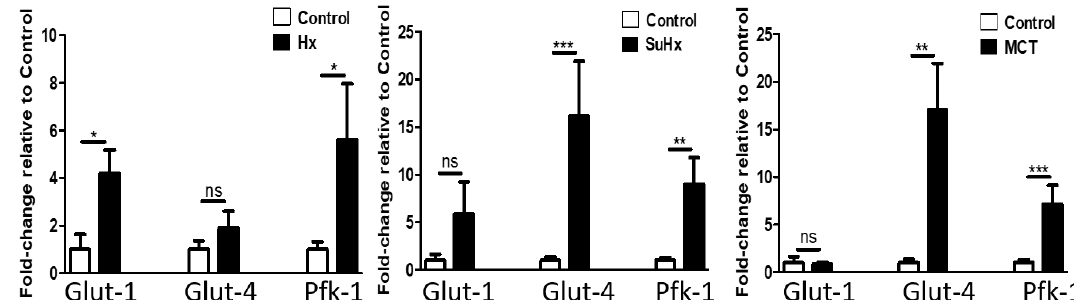
Figure 6. Altered adipose tissue levels of glycolytic marker mRNA in experimental pulmonary hypertension. Data represent mean ± SEM from n = 8–14 animals per experimental group. Statistical analysis by Student’s t -test. * p < 0.05, ** p < 0.005, *** p < 0.001, ns: no